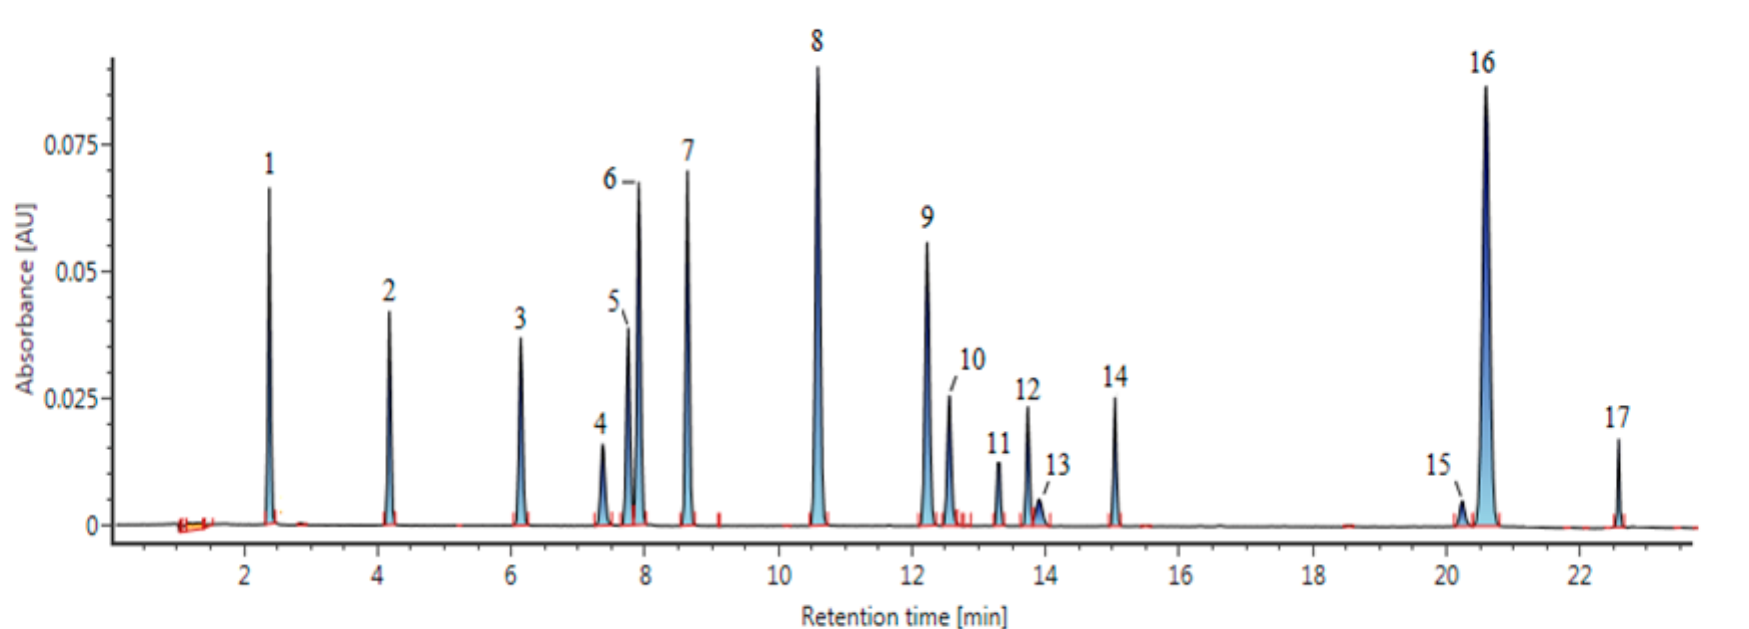
Figure 2. Chromatograms of standard mixture of 17 phenolic compounds at 260 nm. Peaks were identified as follows: (1) gallic acid, (2) 3,4-dihydroxybenzoic acid, (3) 4-hydroxybenzoic acid, (4) 2,4-dihydroxybenzoic acid, (5) vanillic acid, (6) ca ff eic acid, (7) syringic acid, (8) p-coumaric acid, (9) ferulic acid, (10) sinapinic acid, (11) rutin, (12) quercetin 3- β - D -glucoside, (13) benzoic acid, (14) kaempferol 3- O - β -glucoside, (15) quercetin, (16) cinnamic acid, (17) kaempferol.